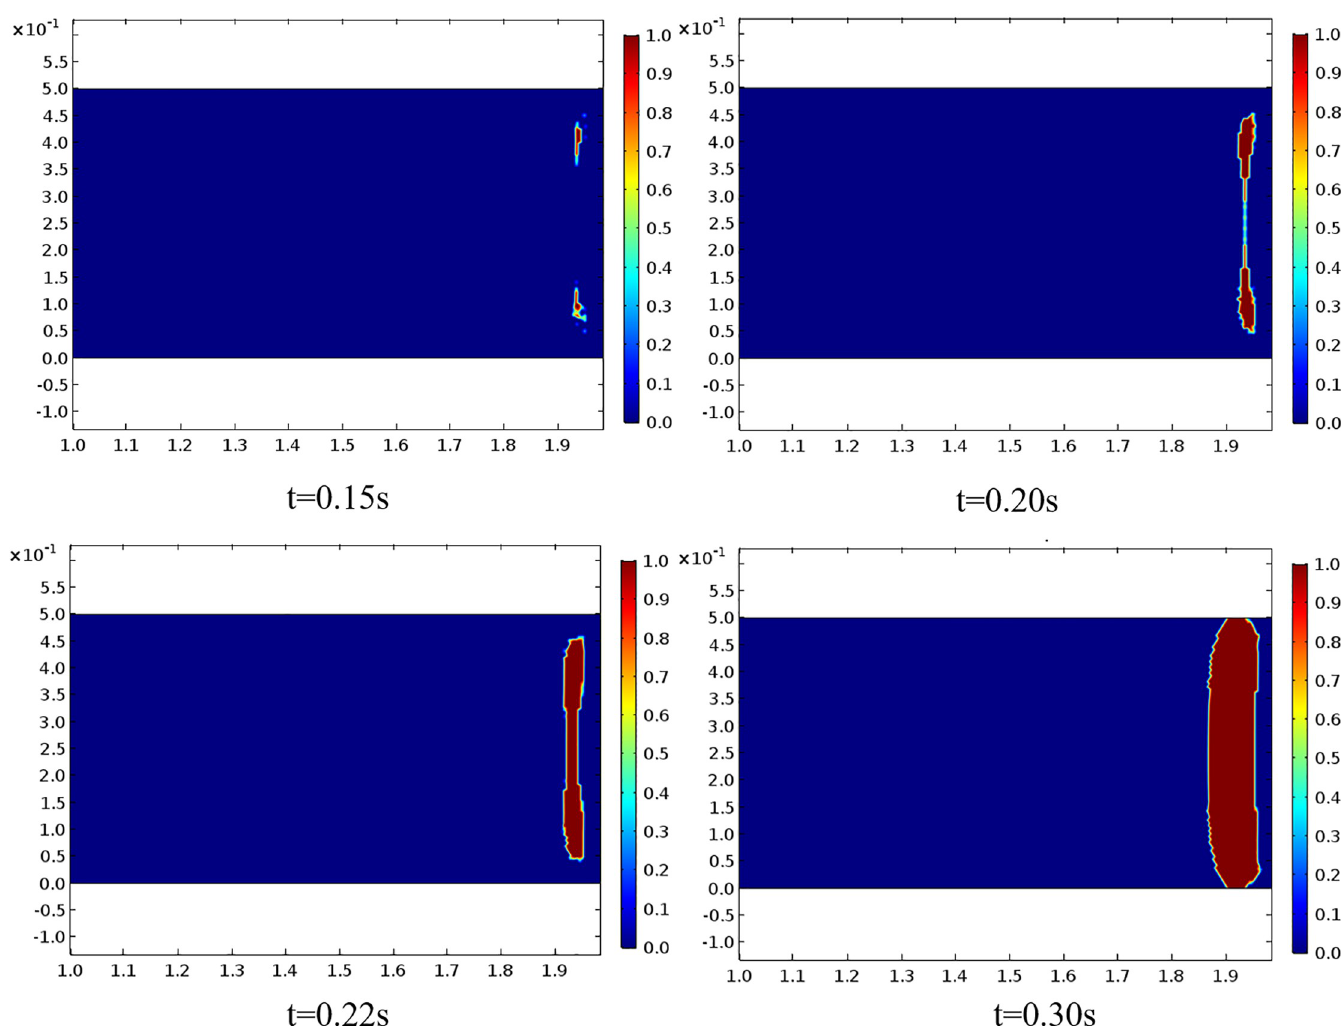
Fig 9. Regional evolution of the maximum first-principal stress above the tensile strength in the solution domain.